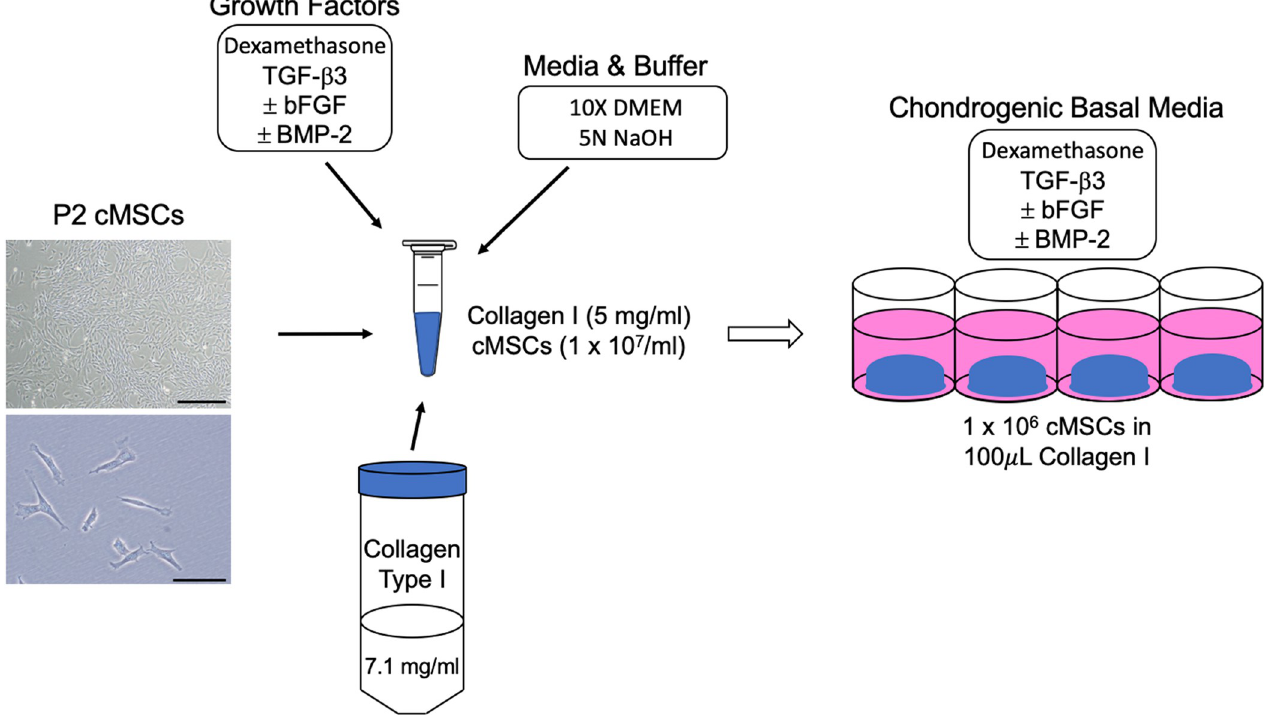
Fig 1. cMSC/Collagen Type I gel fabrication. Collagen Type I isolated from rat tail tendons (7.1 mg/mL) was pipetted into a new, chilled conical tube. Media and 5N NaOH (Table 1) were added at defined proportions and gently incorporated. Passage 2 cMSCs were trypsinized, washed in DMEM to remove FBS, and concentrated to 5 x 10 7 cells/mL. cMSCs were added to the chilled collagen gel to a final concentration of 1 x 10 7 cells/mL. Gels were supplemented with dexamethasone (1 x 10 − 7 ), 10 ng/mL TGF- β 3 (rhTGF- β 3, R&D Systems, Minneapolis, MN), and various combinations of rhBMP-2. Gels were pipetted in 100 μ L aliquots into 24-well plates, allowed to equilibrate at 37˚C for 30 minutes, and supplied with chondrogenic basal medium containing growth factor combinations matching each collagen